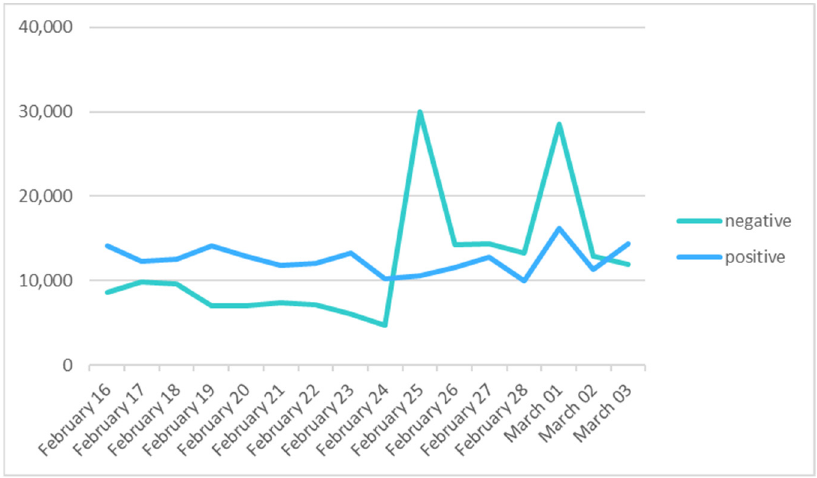
Figure 11. Daily evolution of sentiments.